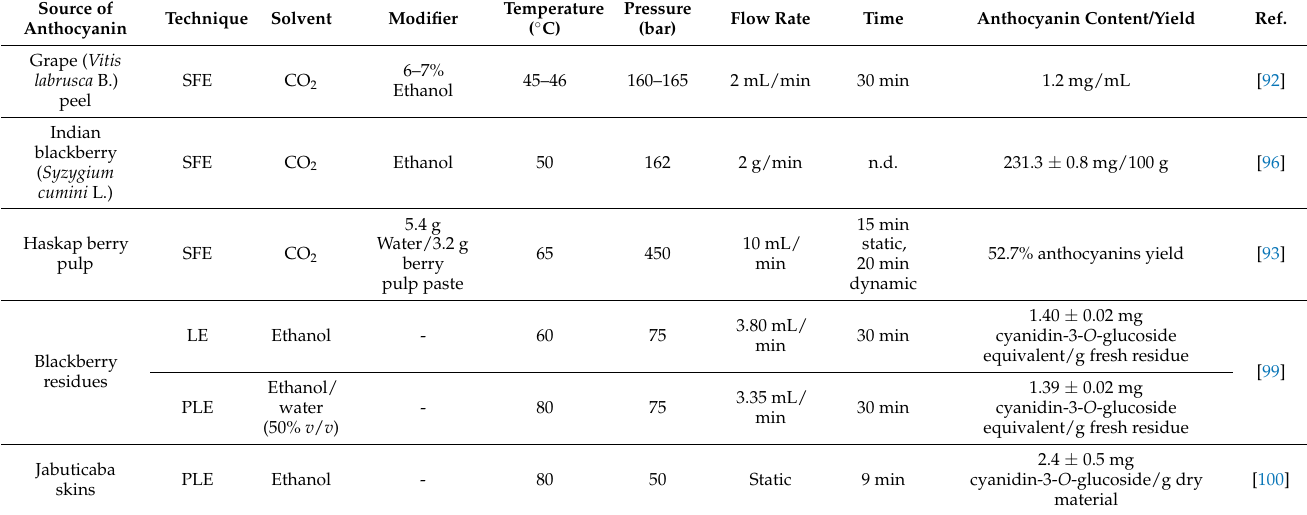
Table 2. Selected studies on separation of anthocyanins using compressed